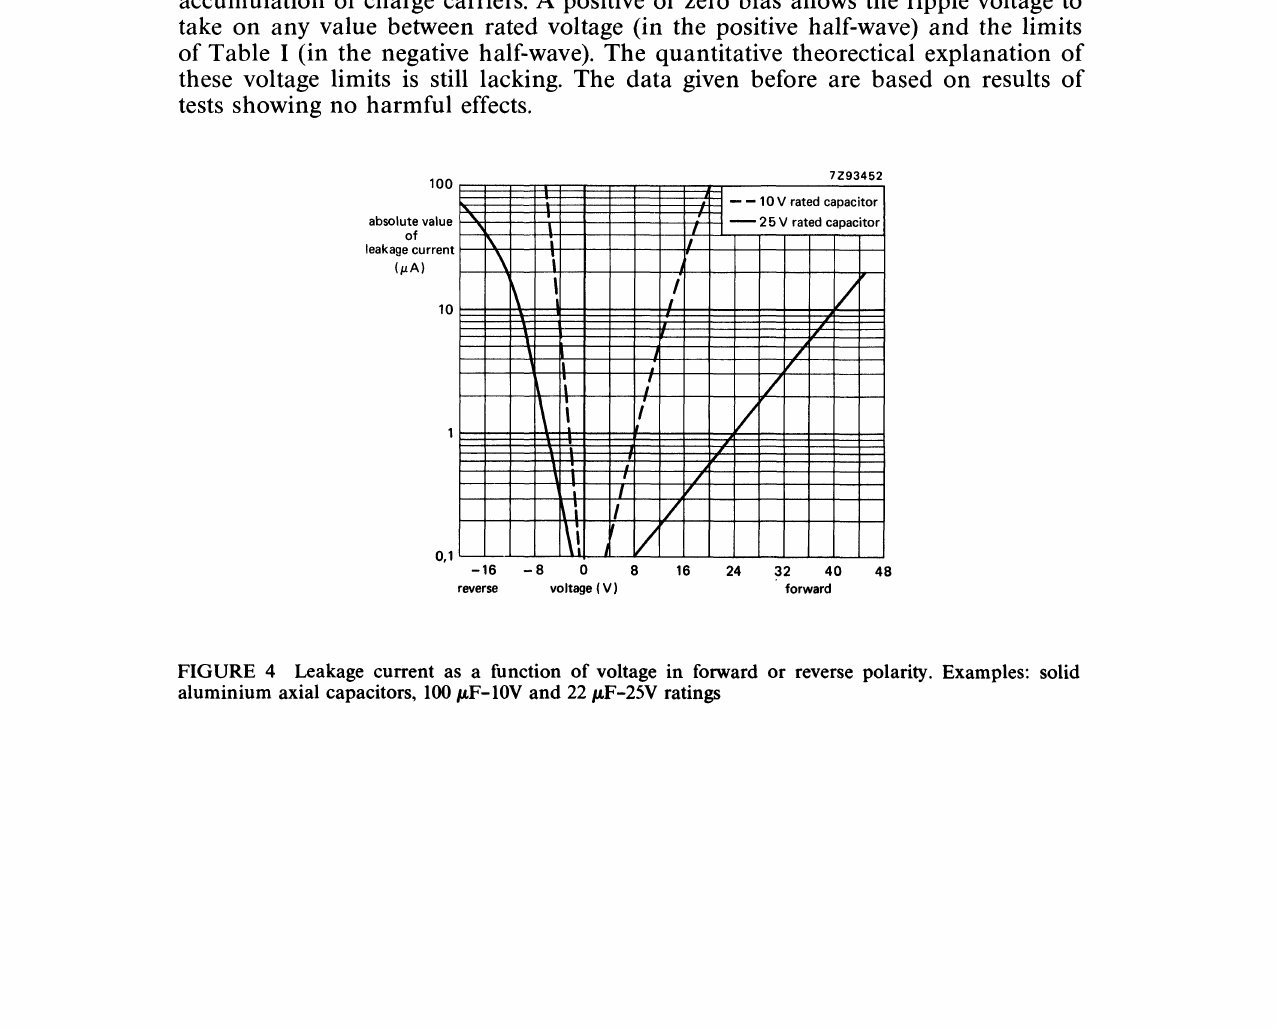
FIGURE 4 Leakage current as a function of voltage in forward or reverse polarity. Examples: solid aluminium axial capacitors, 100 ttF-10V and 22 F-25V